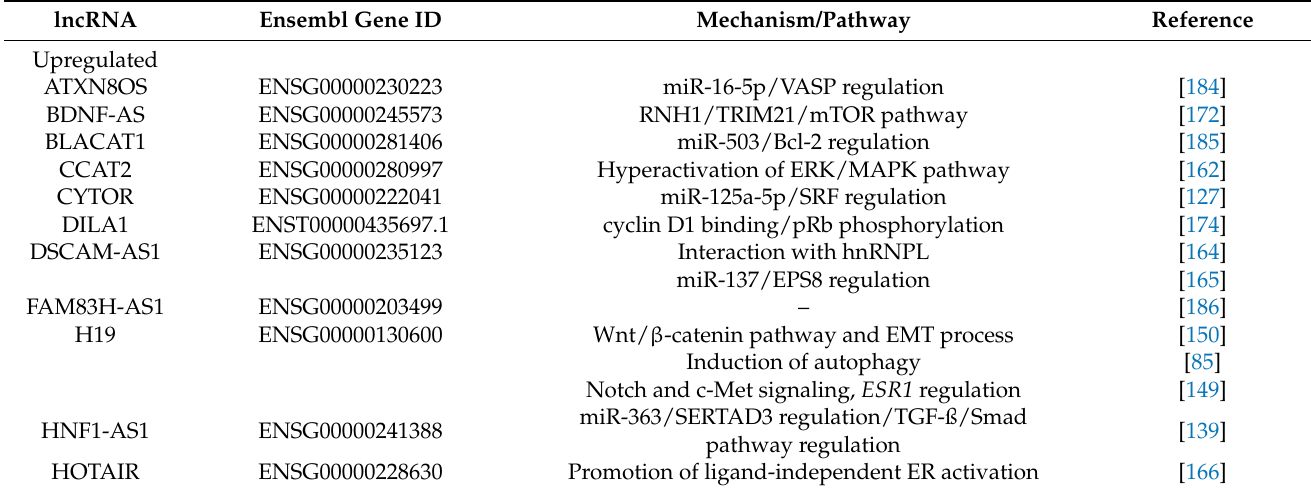
Table 2. LncRNAs associated with tamoxifen